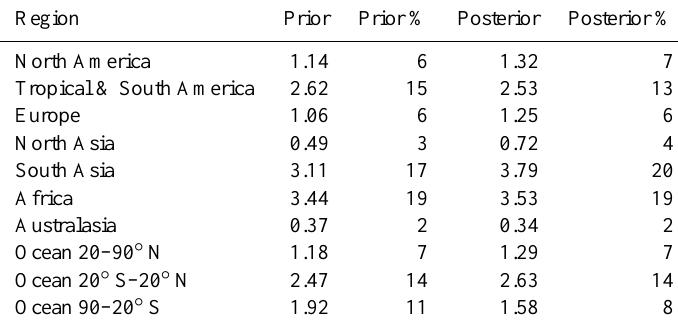
Table 6. Prior and posterior sources (Tga − 1 N) by region. Values are given as the mean over the period 1999 to 2009 and for the posterior source the results of the test IAVA are given.